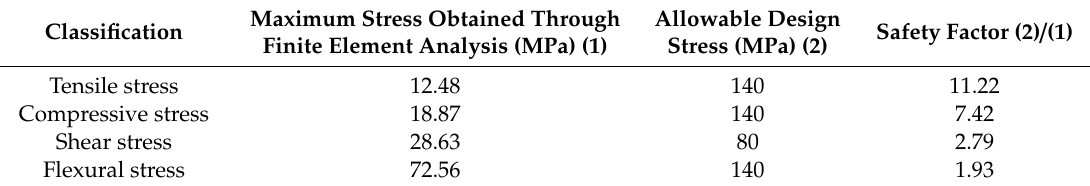
Figure 12. FEA results. ( a ) Tensile stress; ( b ) compressive stress; ( c ) shear stress; ( d ) flexural stress. Table 5. Finite element analysis results.